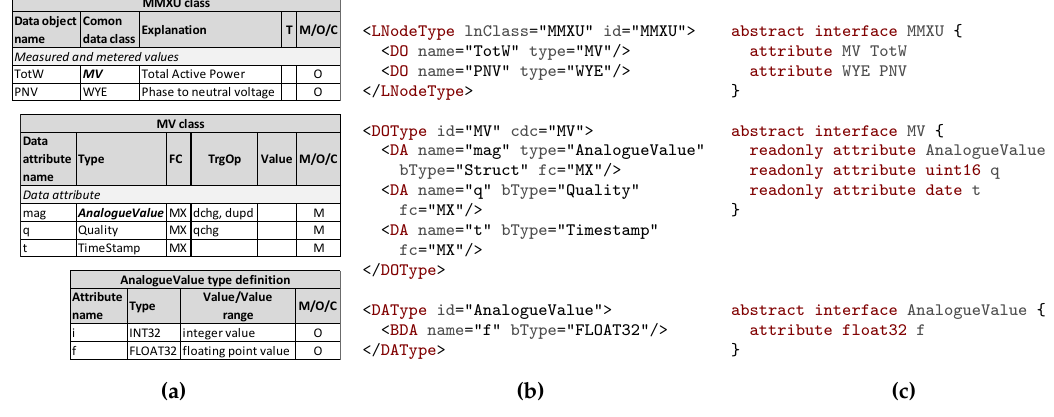
Figure 9. Mapping between an LN 850 and an <interface> : ( a ) Excerpt of the LN 850 MMXU in IEC 61850; ( b ) MMXU as SCL description; ( c ) MMXU as <interface>